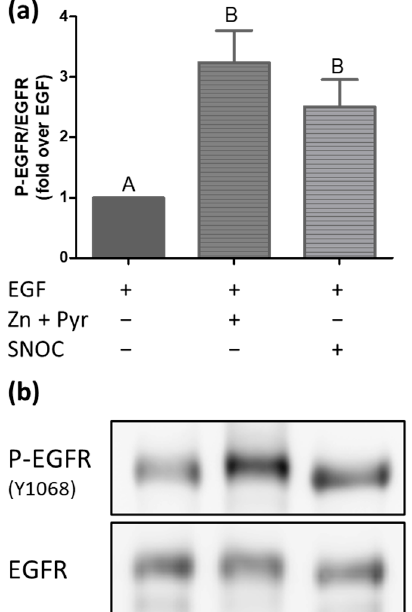
Figure 5. Zinc enhances EGF-induced EGFR phosphorylation. The effect of a simultaneous stimulation with zinc (Zn), pyrithione (Pyr) and EGF or SNOC and EGF on the tyrosine 1068 phosphorylation of the EGFR is shown. A549 cells were stimulated for 60 min with zinc (50 µM), pyrithione (0.5 µM) and EGF (25 ng/mL) or SNOC (2 mM) and EGF (25 ng/mL). Phosphorylation was quantified by Western blotting. Data of n = 12 independent experiments are shown as means + SEM ( a ). One